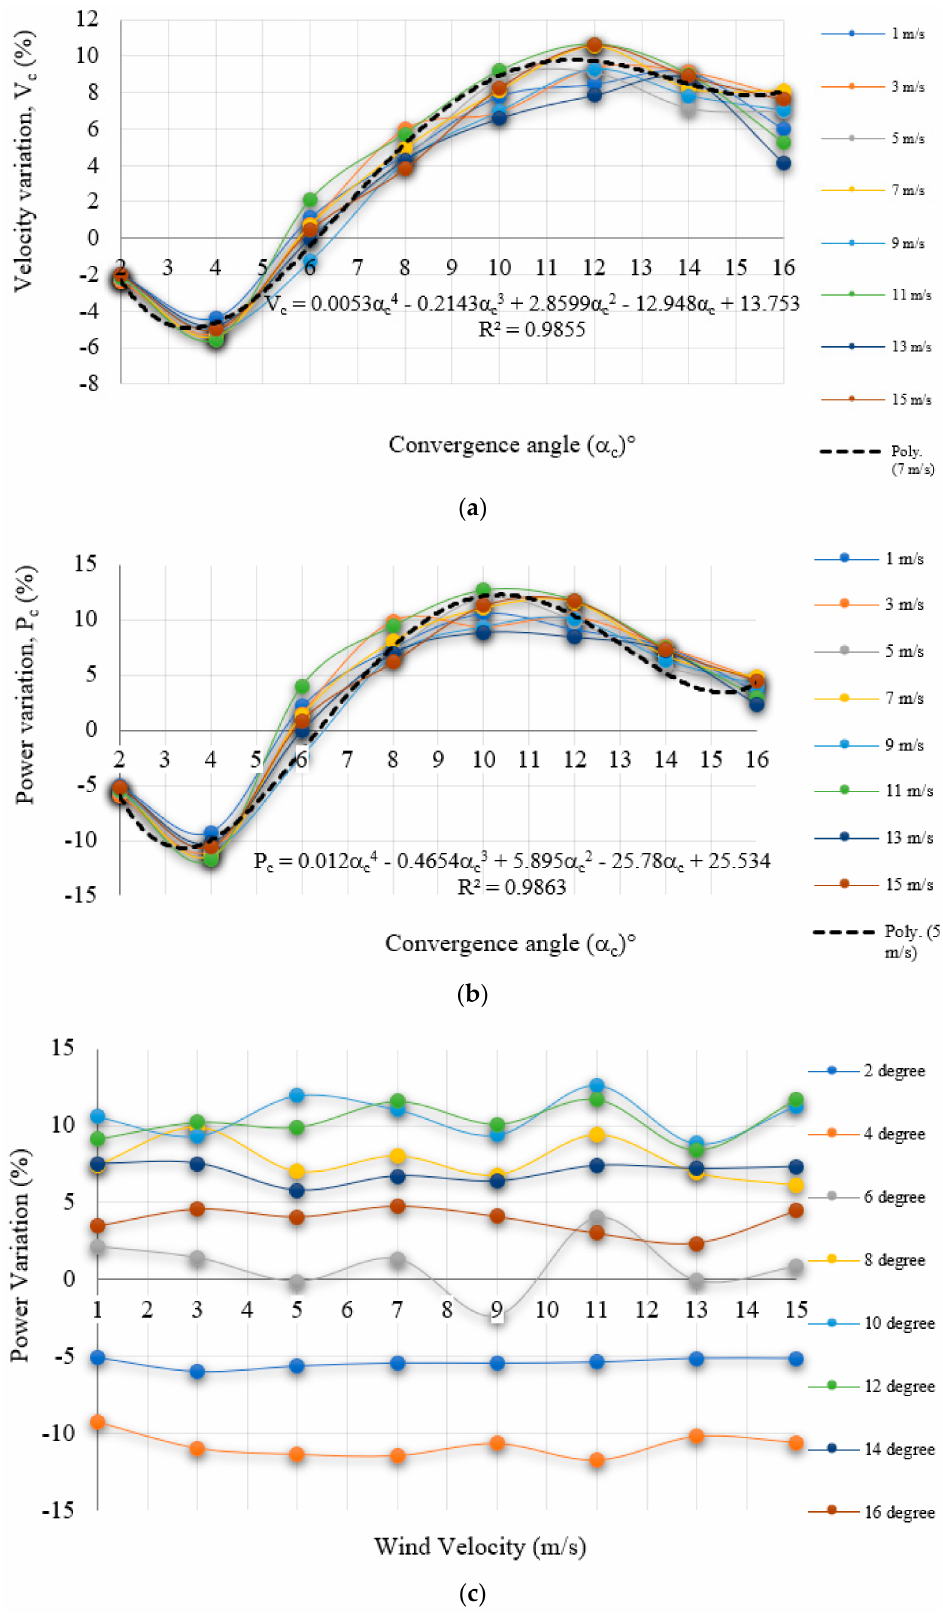
Figure 9. Effect of α c on: ( a ) velocity variation, V c %; ( b ) power variation, P c %, for a concentrator; ( c ) power variation % with respect to the convergence